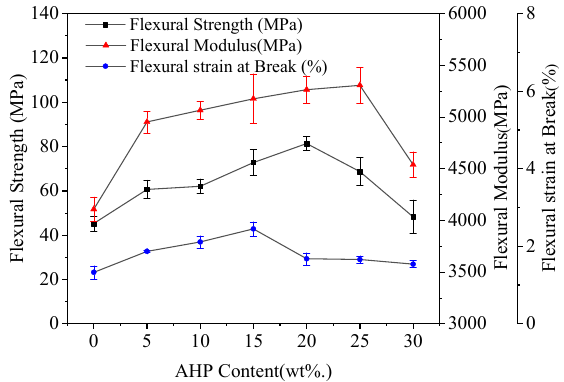
Figure 5. Flexural property curves of BC/PLA/AHP.